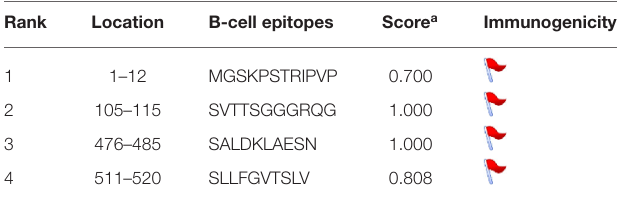
TABLE 4 | DiscoTope structure-based B-cell antibody prediction of chicken F protein